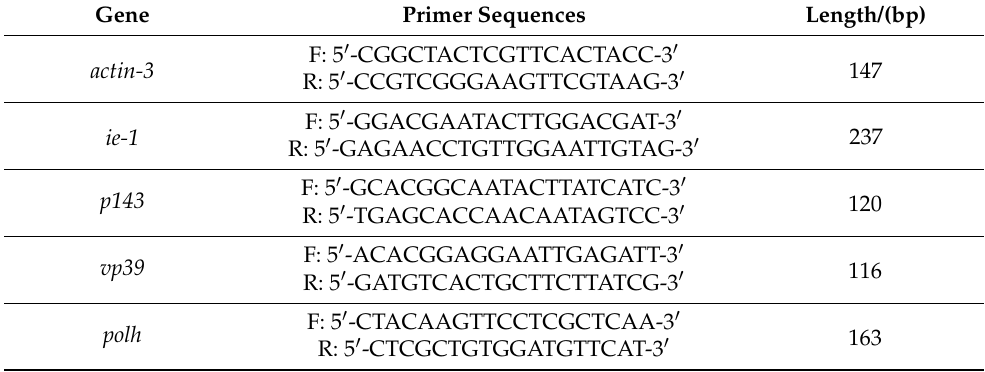
Table 1. Primers used in qPCR.